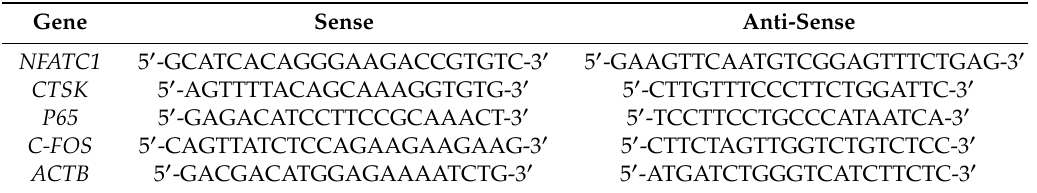
Table 1. Real-time reverse-transcription PCR primer sequences for genes used in this study. Gene